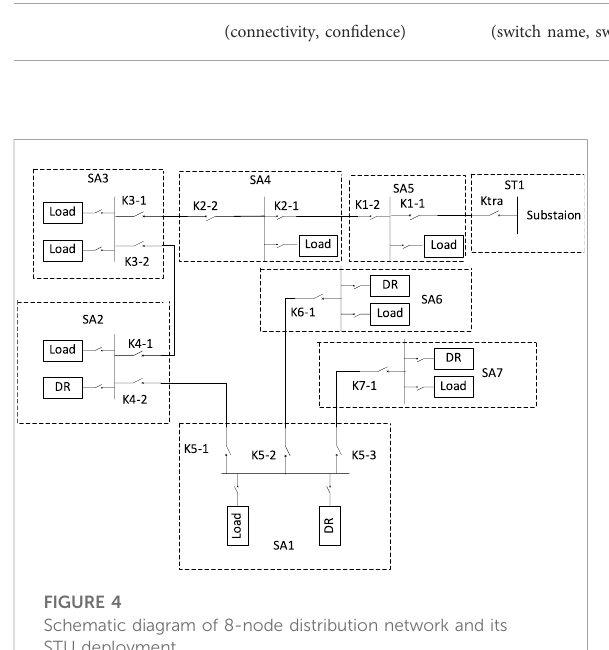
FIGURE 4 Schematic diagram of 8-node distribution network and its STU